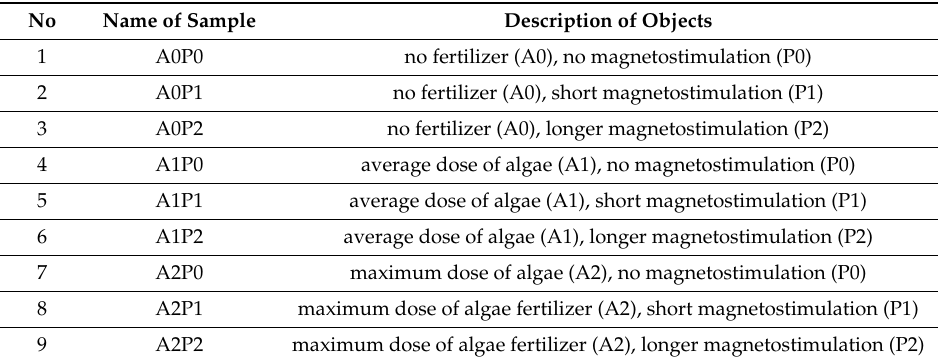
Table 1. Samples and the description of culture